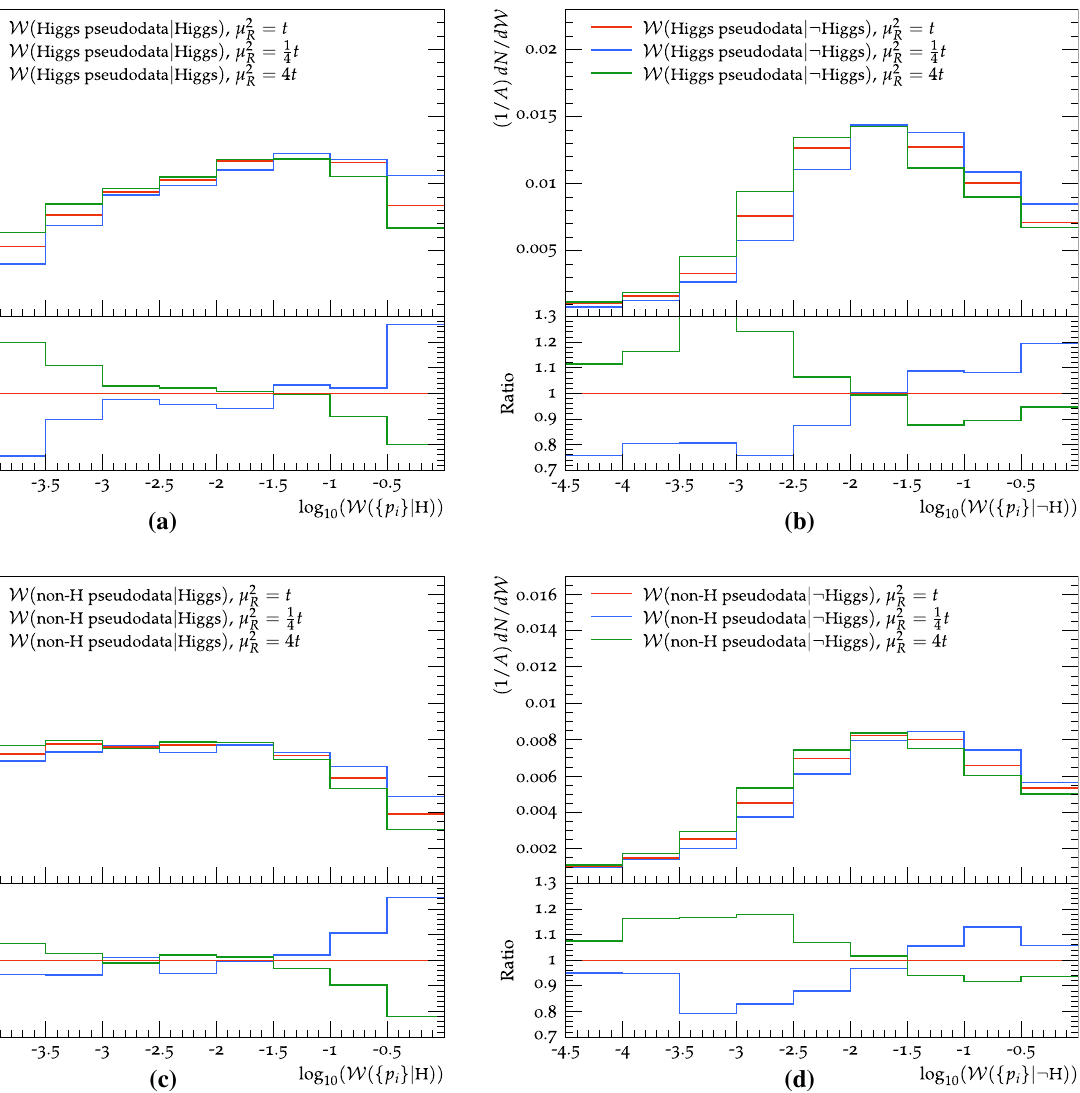
Fig. 3 Non-normalized probabilities W ( { p i }| Hypothesis ) = (cid:8) }| Hypothesis ) · ( P + P + P ) of Higgs and non-Higgs P ( { p i H QCD QED pseudodata to be tagged as Higgs or non-Higgs configuration, using